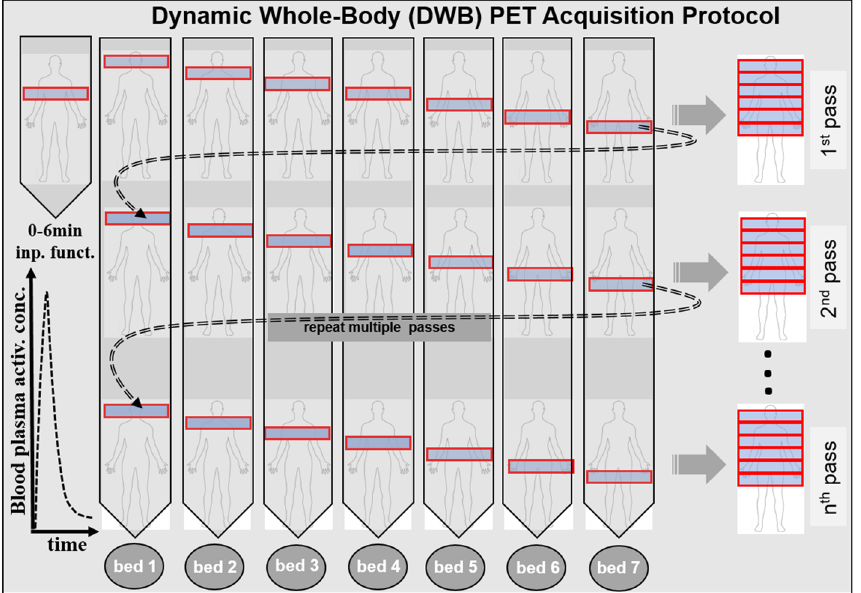
Figure 1. Flow chart illustrating the sequence of all dynamic bed frames, as acquired with the step and-shoot mode during the 2nd phase of the DWB acquisition: 6 unidirectional (cranio-caudal) WB passes are acquired, each comprised of 7 beds of equal scan duration . The figure was drawn using 2016 Microsoft PowerPoint application (Microsoft, Germond, WA, United